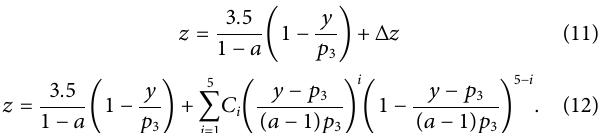
FIGURE 5 Schematic diagram for calculating the TSs of the hull and conning tower. (A) Conning tower. (B) Hull